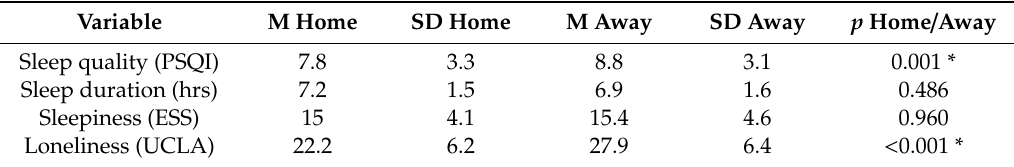
Table 2. Summary of ANCOVA analyses comparing home versus away sleep quality, sleep duration, sleepiness, and